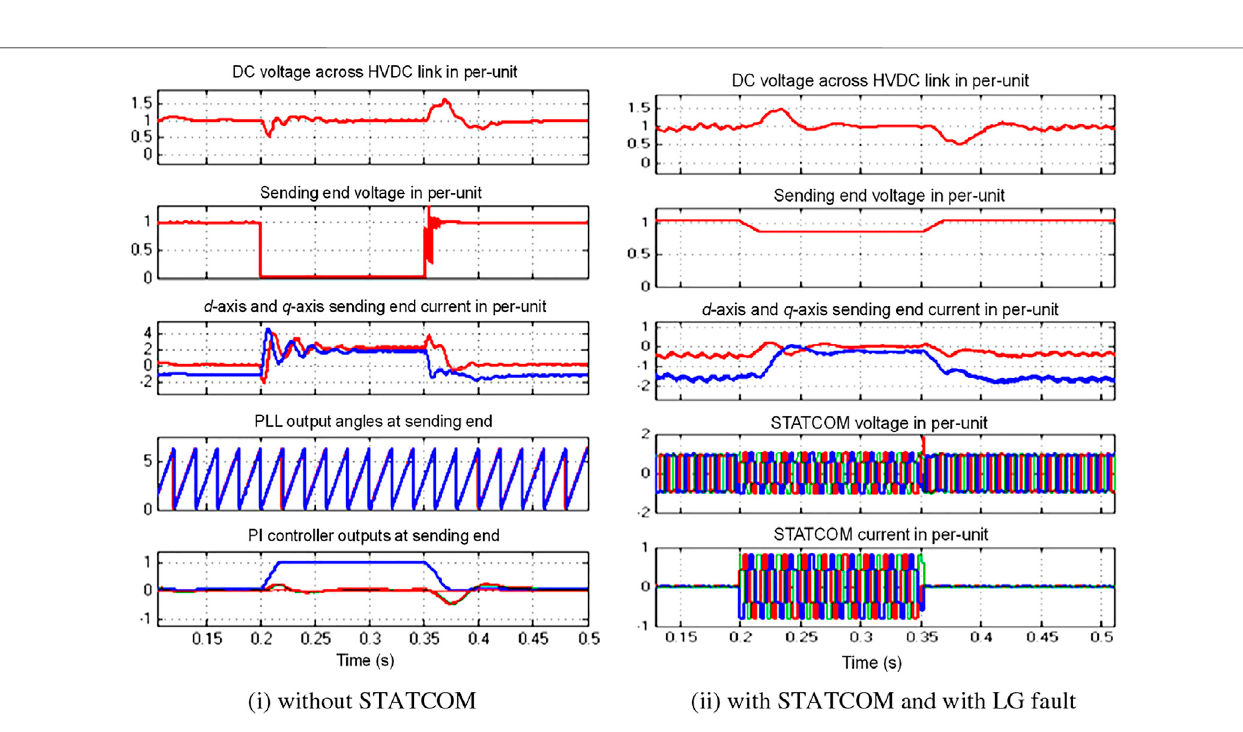
Frontiers in Energy Research |